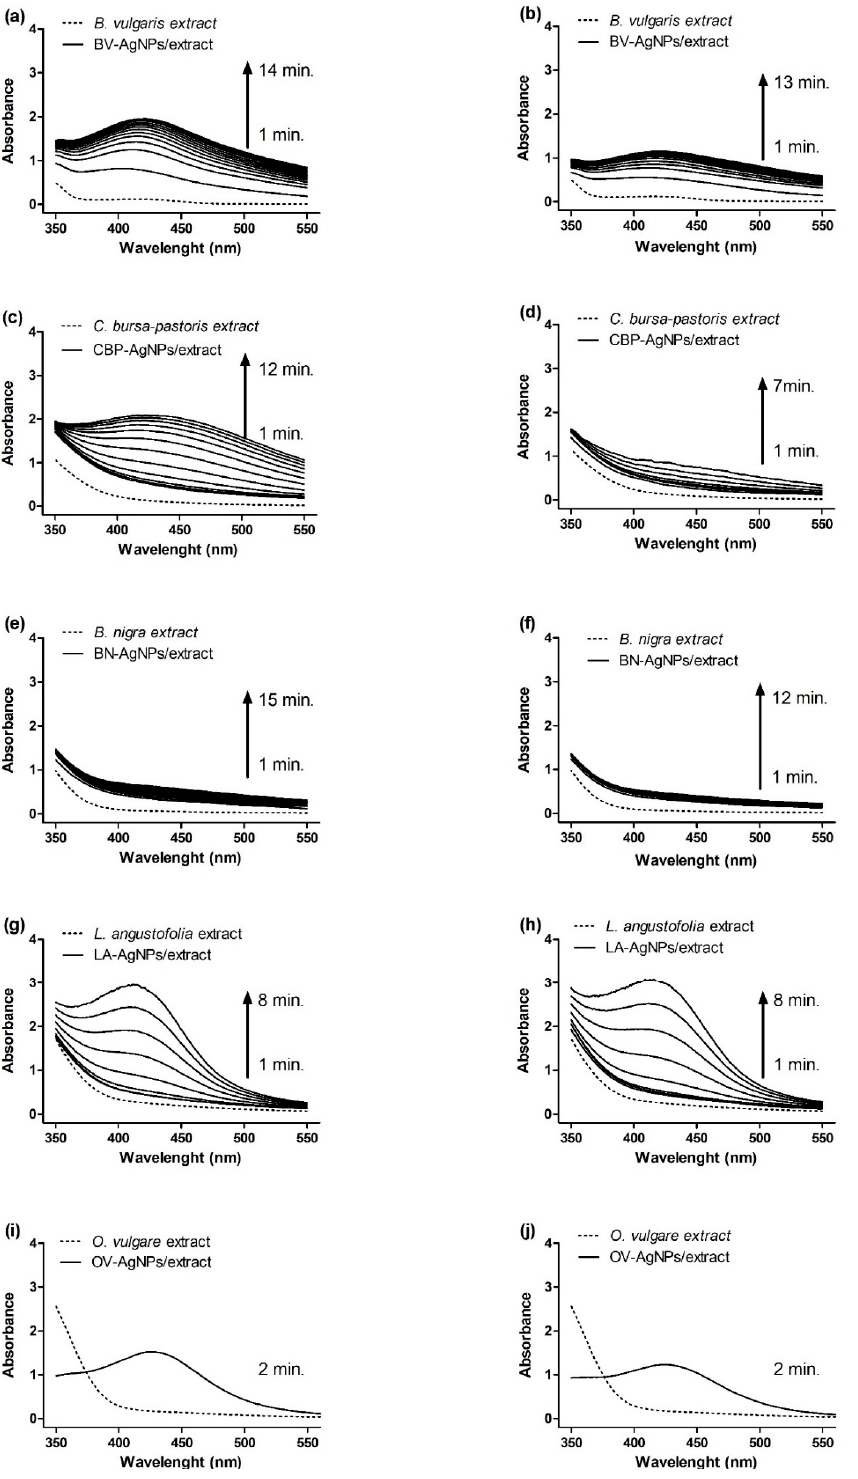
Figure 1. UV-Vis spectra of plant extracts (dash line) and biosynthesised silver nanoparticles (AgNPs) (solid line) prepared from 2 mM ( a , c , e , g , i ) and 5 mM AgNO 3 ( b , d , f , h , j ). In the case of CBP-AgNPs and BN-AgNPs, almost no signal was detected in the monitored region. Interestingly, a weak peak located at 422 nm was observed in the case of CBP-AgNPs (2 mM), whereas for 5 mM, it was not observed. During the aggregation of the AgNPs, metal particles become electronically coupled and this system has a